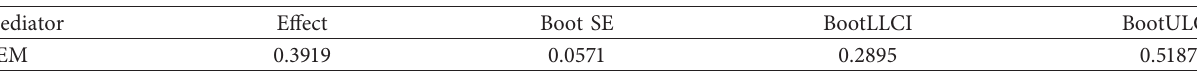
Table 6: The mediating effect of the consumption between integrity of mobile sales terminal and continual intention.